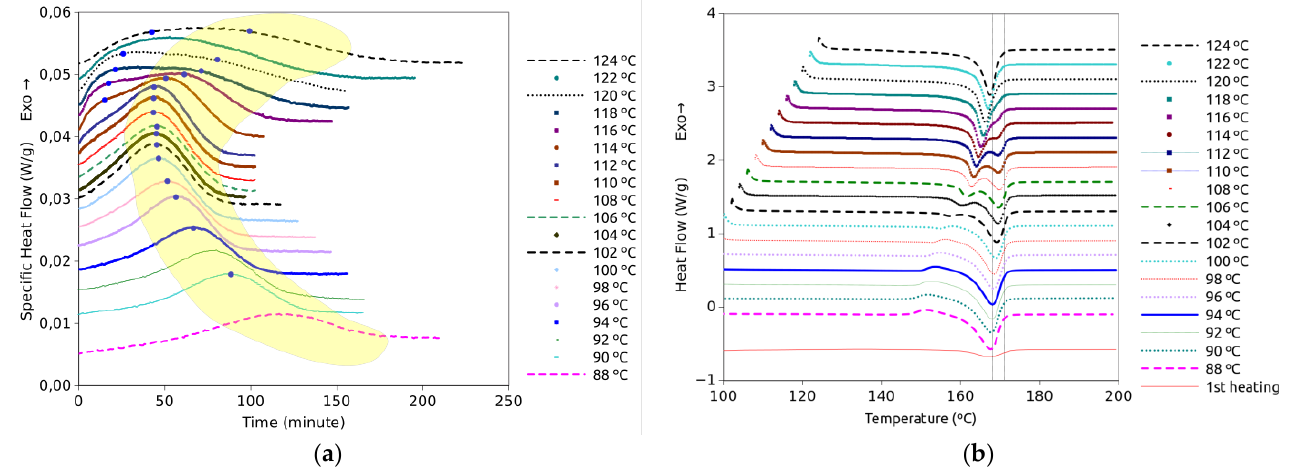
Figure 2. DSC isothermal plots obtained from the melt at the indicated temperatures ( a ) and plots from heating scans following each of the isothermal treatments ( b ). Vertical lines are aimed to better observe peak